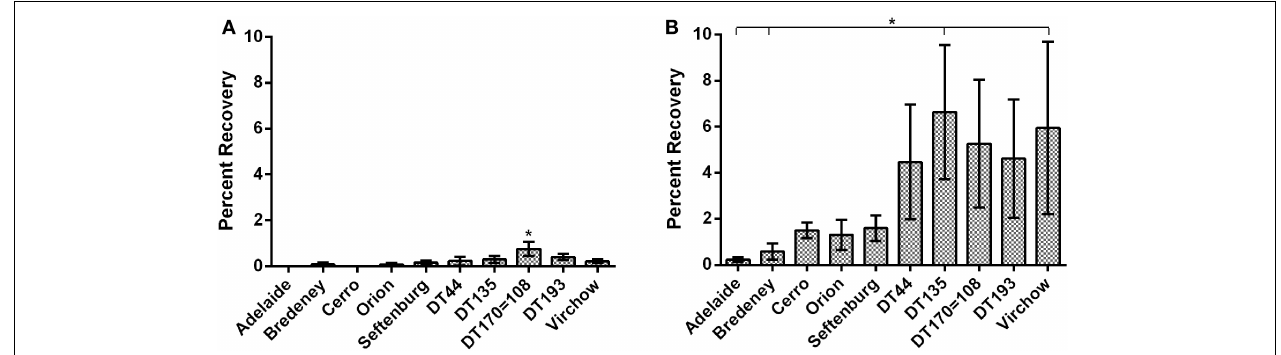
FIGURE 1 | The invasive potential of Salmonella strains was characterized using polarized Caco2 cells. Data are represented as percent invasion. (A) Invasion potential of bacteria suspended in normal saline. S. Typhimurium DT170 = 108 suspended in normal